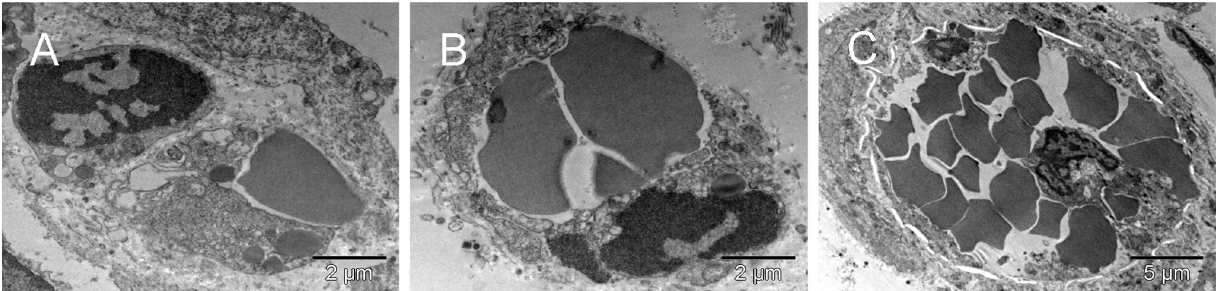
Figure 3. Extramedullar erythropoiesis via nucleo-cytoplasmic conversion. The single cells undergoing structural remodeling in the nucleus and cytoplasm [ A & B ] represented at slightly different stages of erythropoiesis. Conceivably, a few such cells, when gathered into a cluster, could fill up a larger space with erythrosomes creating a cobble stone pattern, also called ‘erythropoietic lake’ or myeloplaxes [ C ]. Platelets and megakaryocyte were recognizable at the periphery of the cluster.